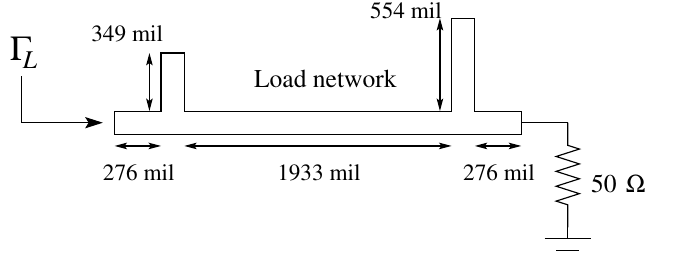
Figure 6. Schematic of the first passive load circuit (Load Circuit 1). The width of all the microstrip lines is 136.7 mil.